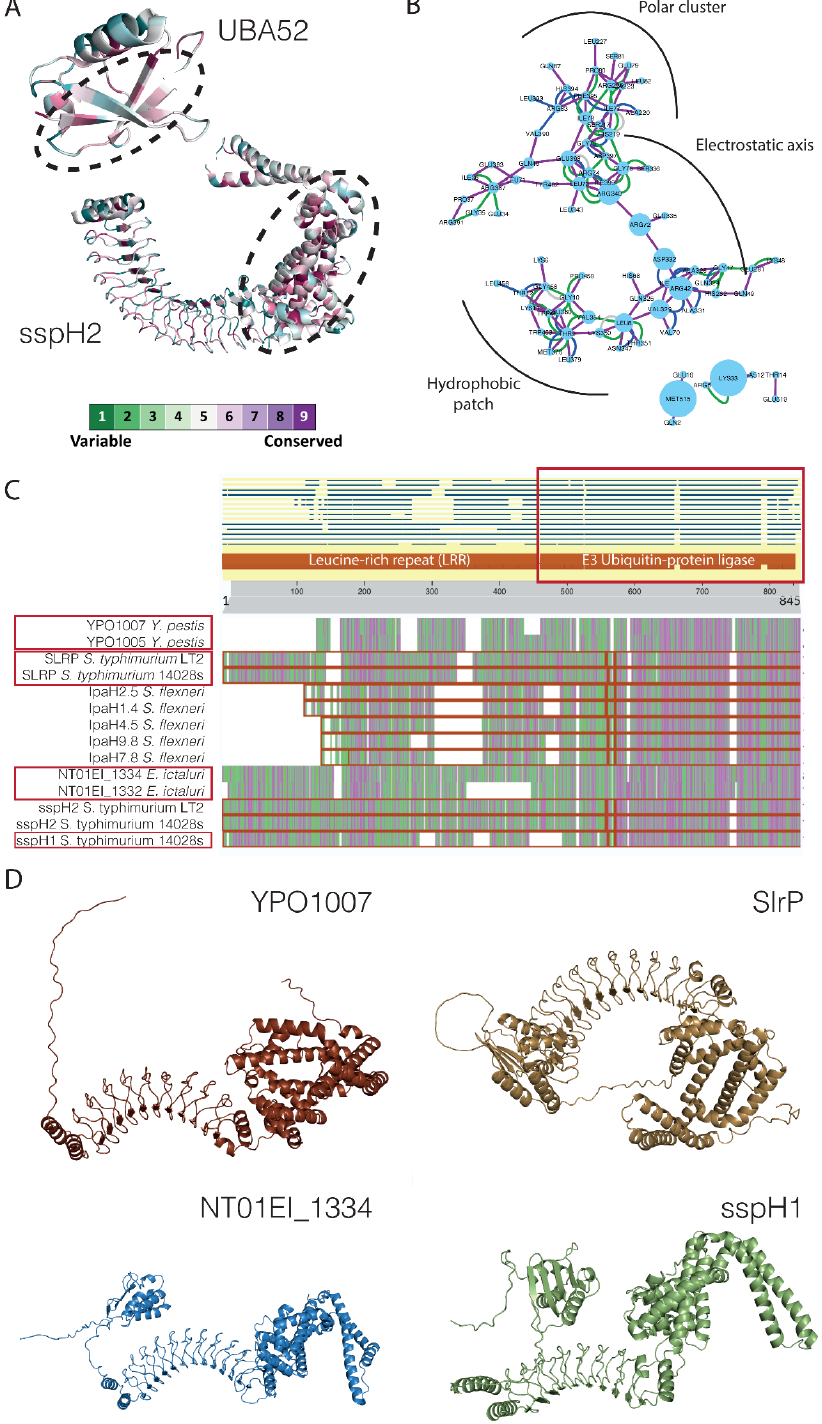
Figure 9. Analysis of complexes between IpaH and sspH2 with ubiquitin UBA52. ( A ) Structure of UBA52 and sspH2 showing the degree of sequence conservation. The conservation scale is displayed at the bottom of the figure. ( B ) Residue contact network between UBA52 and sspH2 showing several contact signatures. ( C ) Blast search results using the ubiquitin-protein ligase domain as the query sequence. Newly identified domains are highlighted by brown boxes. ( D ) Predicted structures of selected proteins using Alphafold